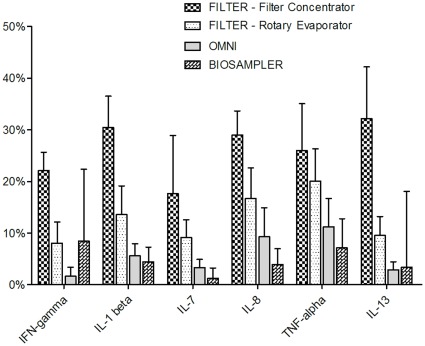
Comparison of sampling device collection efficiencies by cytokine.Collection efficiencies calculated using Equation 3 for each of six different human cytokines using different collection devices in a single-pass aerosol chamber (N = 6; 3 filters assayed in duplicate, 95% CI).